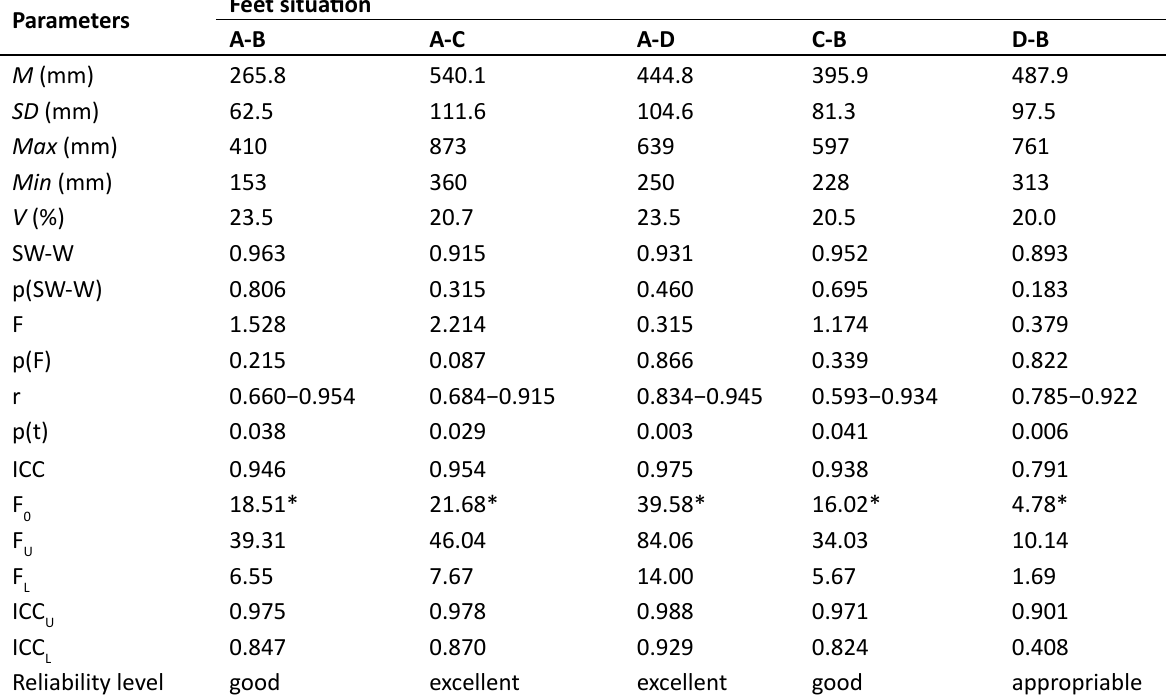
Table 1. Results on the balance